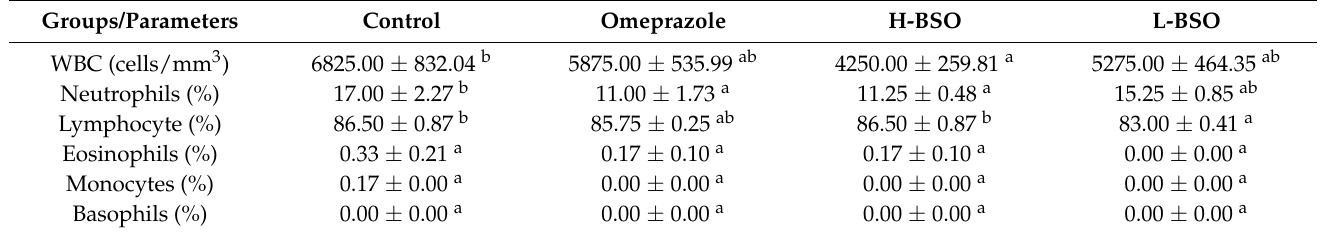
Table 2. White blood cell count (WBC) and differential WBC in blood of rats pretreated with distilled water, omeprazole, H-BSO, and L-BSO in the ethanol-induced gastric ulcer model.